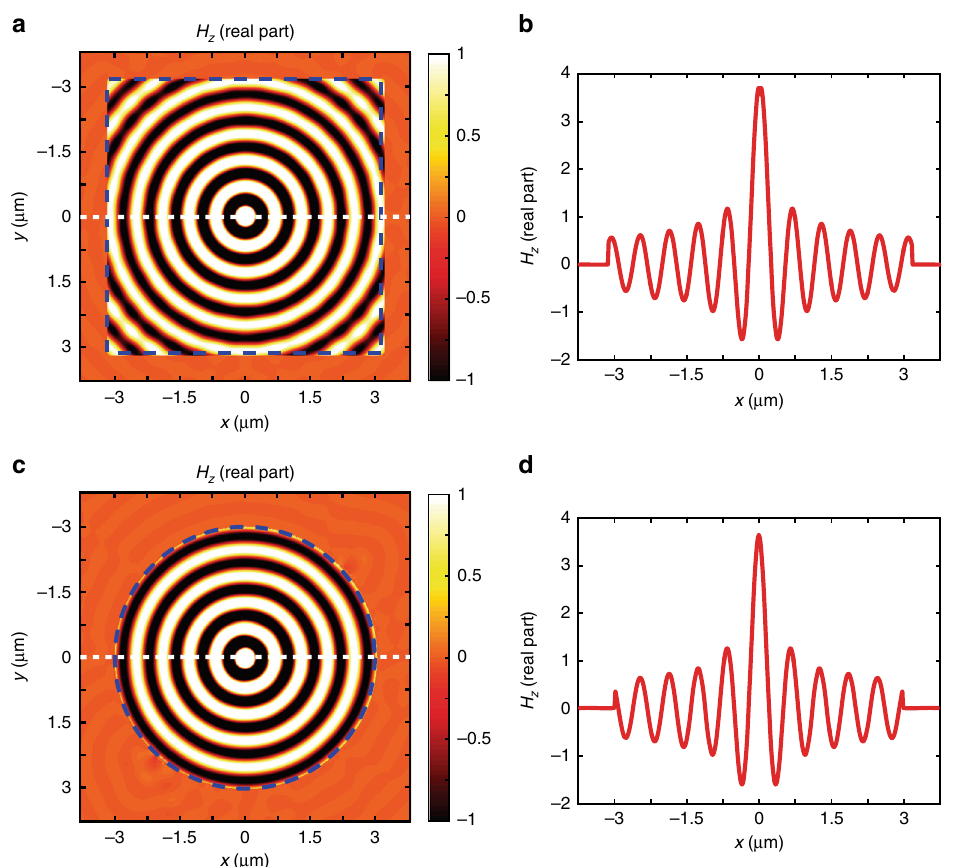
Fig. 2 Arbitrary shaped perfect absorbing layers. Results of numerical simulation showing the magnetic fi eld intensity distribution (real part of H z fi eld) of a point source located in x = 0, y = 0. The emitted light propagates towards a perfectly absorbing metasurface. a Magnetic fi eld intensity distributions of planar absorbing metasurface disposed along the dashed blue rectangle. c light fi eld intensity distributions of cylindrical absorbing metasurface disposed along the blue dashed circle. Both metasurface geometries — planar and conformable — present high extinction ratio and negligible re fl ection, indicating that metasurface boundary conditions can be used as ultrathin perfect absorbing layers. b and d show the cross pro fi le of the fi eld distribution along the x axis at plane y = 0 as indicated by the white dashed line in a and